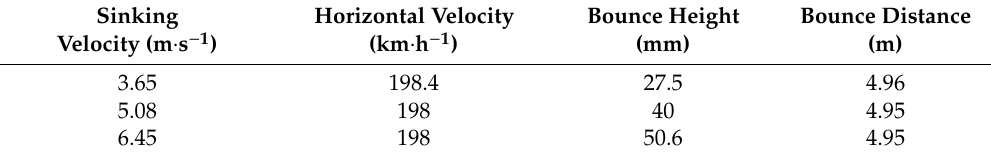
Table 4. Test result of bounce height and bounce distance with di ff erent sinking velocity.